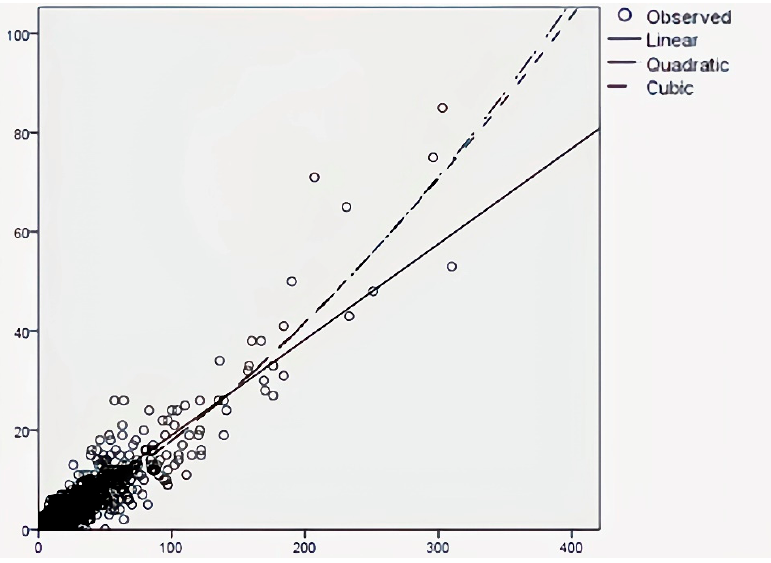
Figure 4. Curve regression of bids and winning bids.